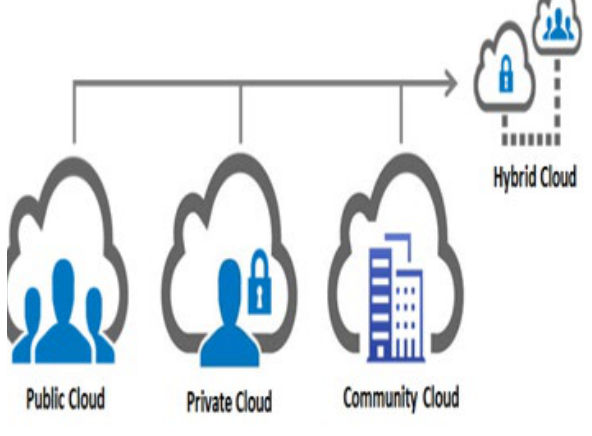
Figure 6. Microsoft Azure Hybrid Cloud